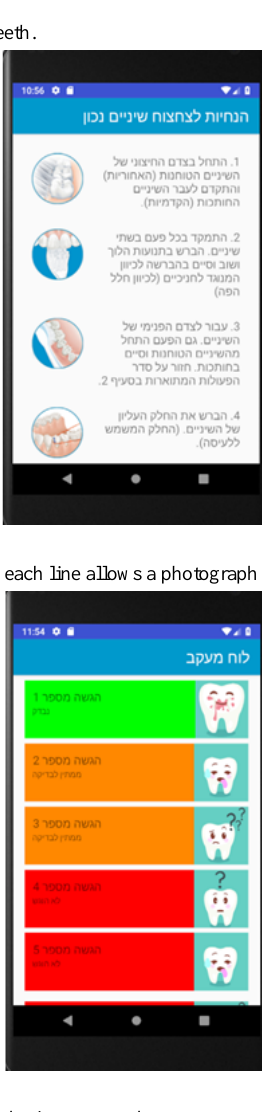
Figure 16. Photo panel screen for the patient: Clicking on the icon opens the